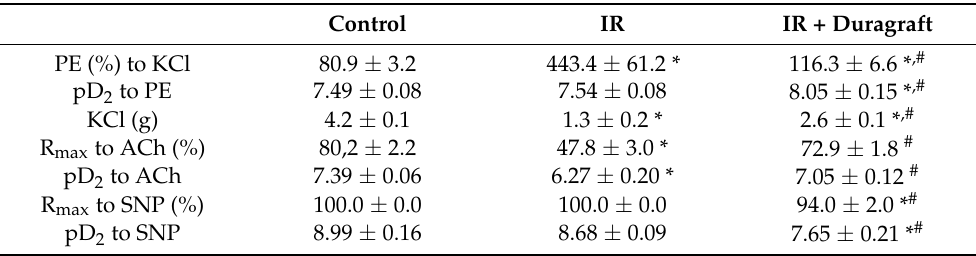
Table 1. Quantitative analysis of vascular function after treatment with DuraGraft ® against is- chemia/reperfusion (IR)